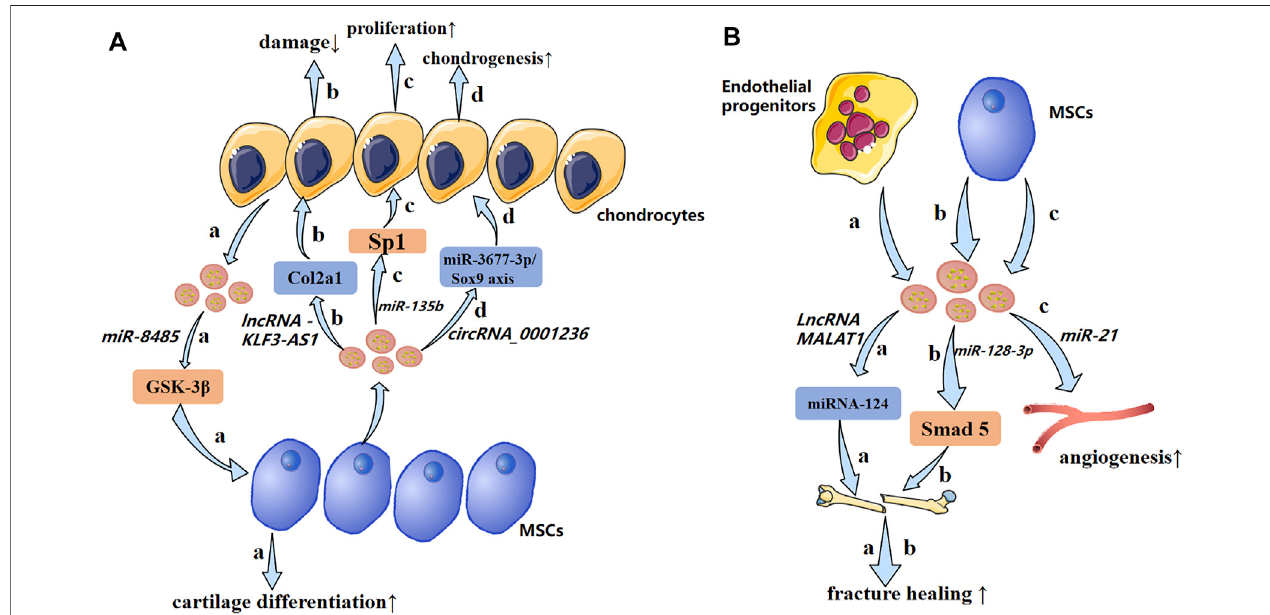
FIGURE 5 | A possible mechanism of exosomal non-coding RNAs in osteoarthritis and impaired fracture healing (schematic). (A) Exosomal non-coding RNAs secretedbychondrocytesandMSCsproducepathologicaleffectsoneachotherthroughdifferentmechanisms. (B) EndothelialprogenitorsandMSCspromotefracture healing and angiogenesis by transporting lncRNAs and miRNAs, respectively. ↑ : promotion; ↓ : inhibition.